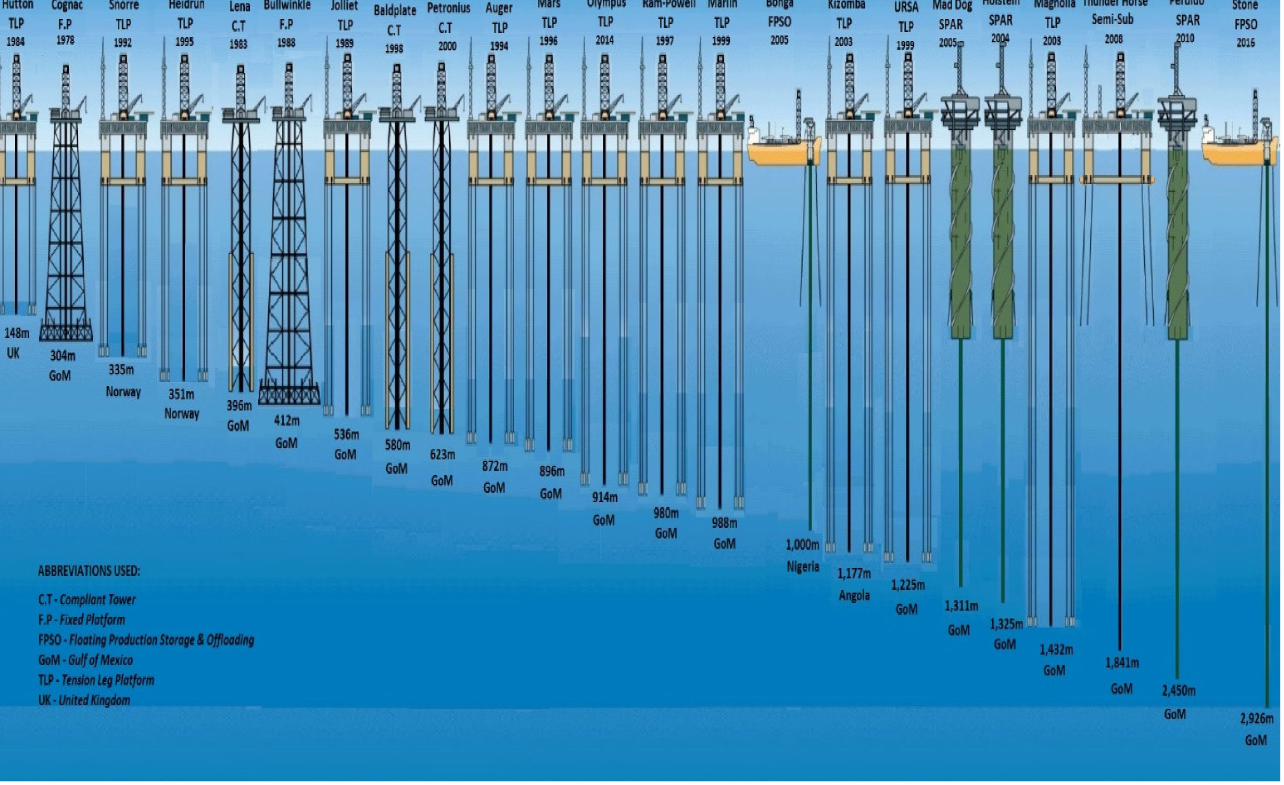
Figure A2. History of Offshore Deep water platforms showing different offshore platforms, their water depths and installation years [Image Credit: Author 1—C.V.A.].